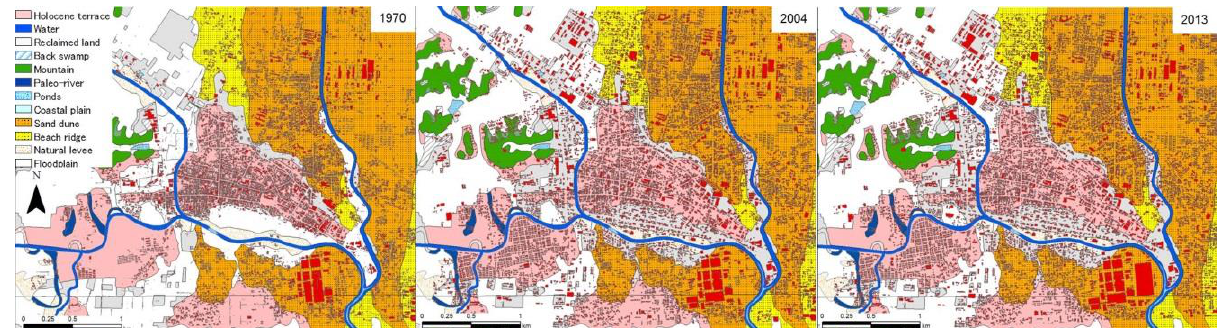
Figure 6. Expansion of the built-up area and geomorphological classification map in the central Mobara City. Red features indicate the